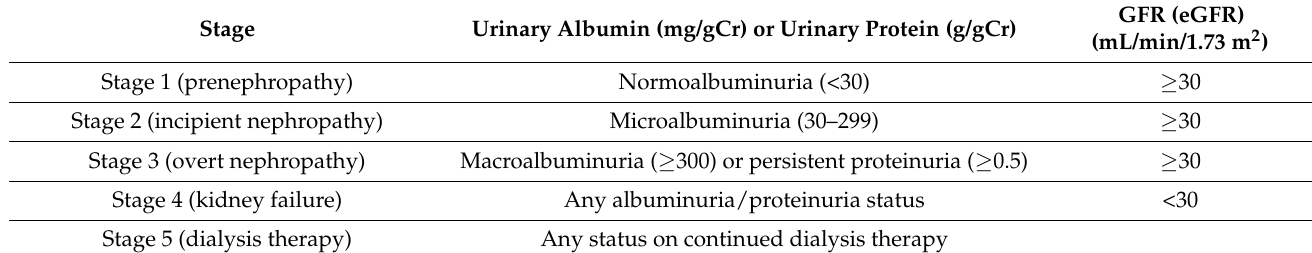
Table 1. Classification of DKD 2014 (From Haneda, et al.